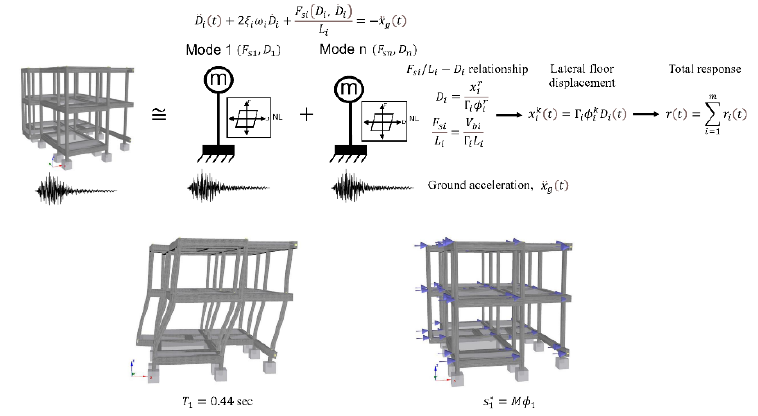
Figure 13. Schematic presentation of the UMRHA procedure.